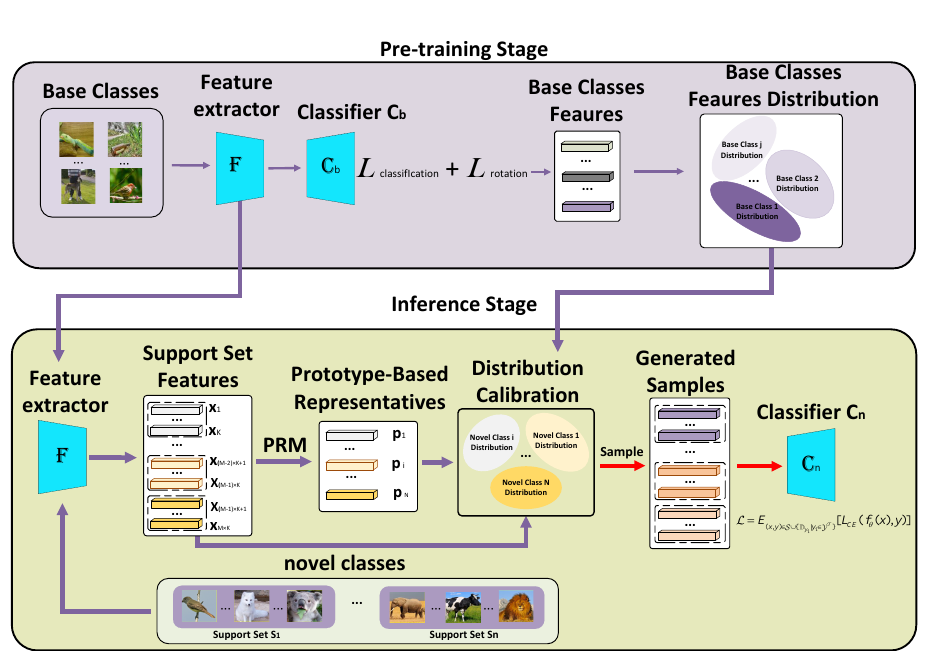
Figure 1. The pipeline of distribution calibration with the Prototype-based Representative